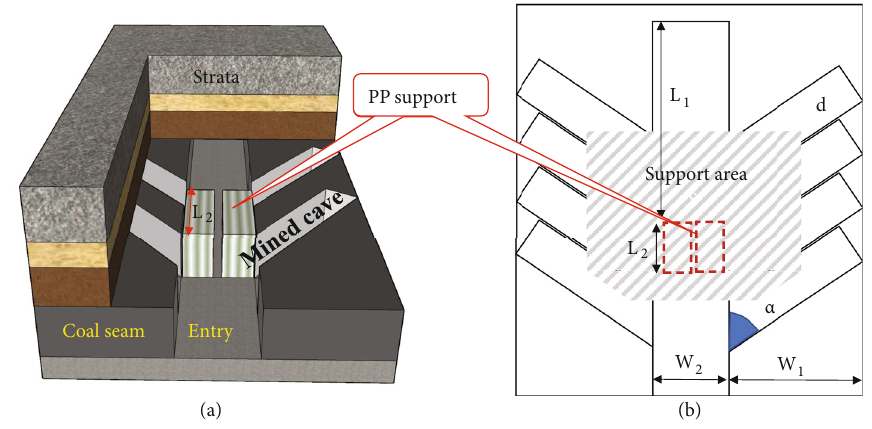
Figure 2: Schematic diagram of the PP support area.